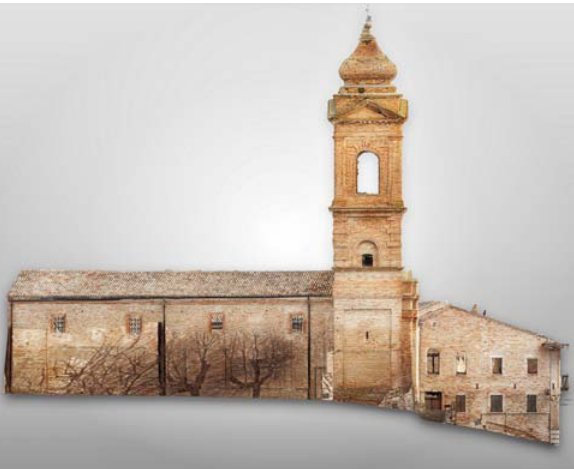
Figure 11. Orthogonal projection of 3D model with rough